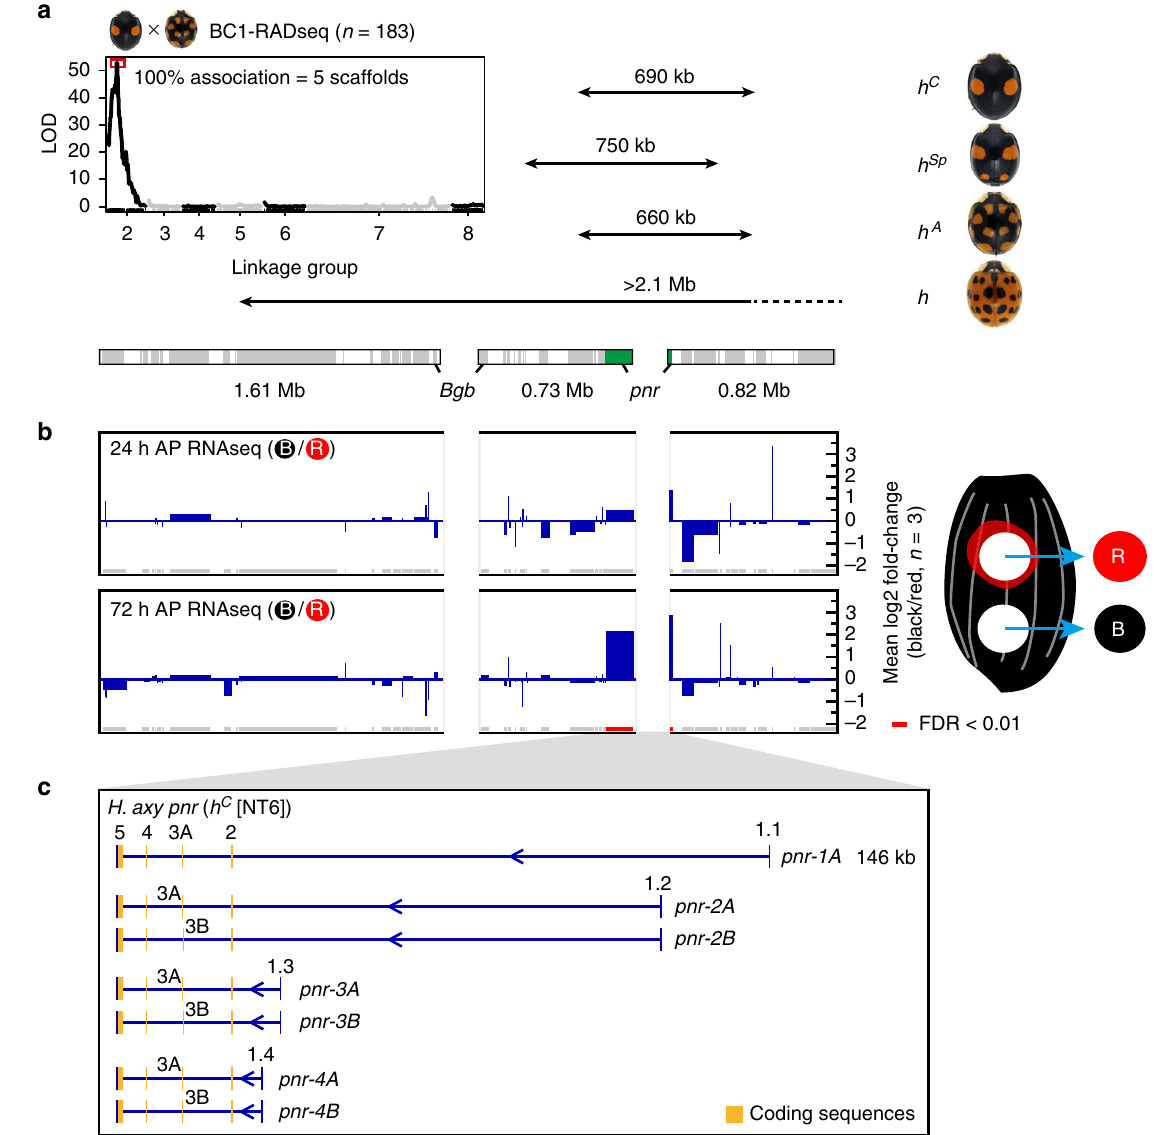
Fig. 4 pannier is the major elytral colour pattering gene located at the h locus. a Genetic association studies of the h locus. Upper left panel, LOD plot for 4419 RAD tags deduced from genotyping BC1 progeny from the h C − h A F0 cross. RAD tags showing segregation patterns of markers located on the X chromosome were excluded from the analysis. The LOD score peaked at RAD tags in Linkage Group 2. RAD tags with complete association with elytral colour patterns corresponded to fi ve genomic scaffolds including the three scaffolds adjacent to the pannier locus (lower bars). Upper right panel, the candidate genomic regions responsible for the major four h alleles. Lower bars, the three genomic scaffolds adjacent to the pannier locus. Grey, genes predicted from RNA-seq. Green, the pannier locus. Contiguity of the scaffolds was predicted based on the truncated genes at the end of scaffolds ( Bgb and pnr ( pannier )). Arrows indicate the respective candidate genomic regions responsible for each allele. pannier is included in all four relevant regions. The images of ladybird beetles are adapted from Fig. 1b. b Fold changes of gene expression in the presumptive red and black elytral epidermis around the candidate genomic region responsible for h . Grey and red bars on the bottom indicate predicted genes. Red, FDR < 0.01. Only pannier was signi fi cantly upregulated in this region at 72 h AP. The samples for RNA-seq were collected as depicted in the right panel in the h C background. c Gene structures of pannier in H. axyridis . Exon number is indicated above each exon. 1A isoform cDNA was cloned by rapid ampli fi cation of cDNA ends (RACE). 2A − 4B isoforms were predicted from RNA-seq analysis. pannier has at least four transcription start sites. Coding sequences are located from exon 2 to exon 5 (yellow). There are two alterative exons at exon 3 (3A and 3B), one encoding one of the two zinc fi nger domains of Pannier (A isoforms), and the